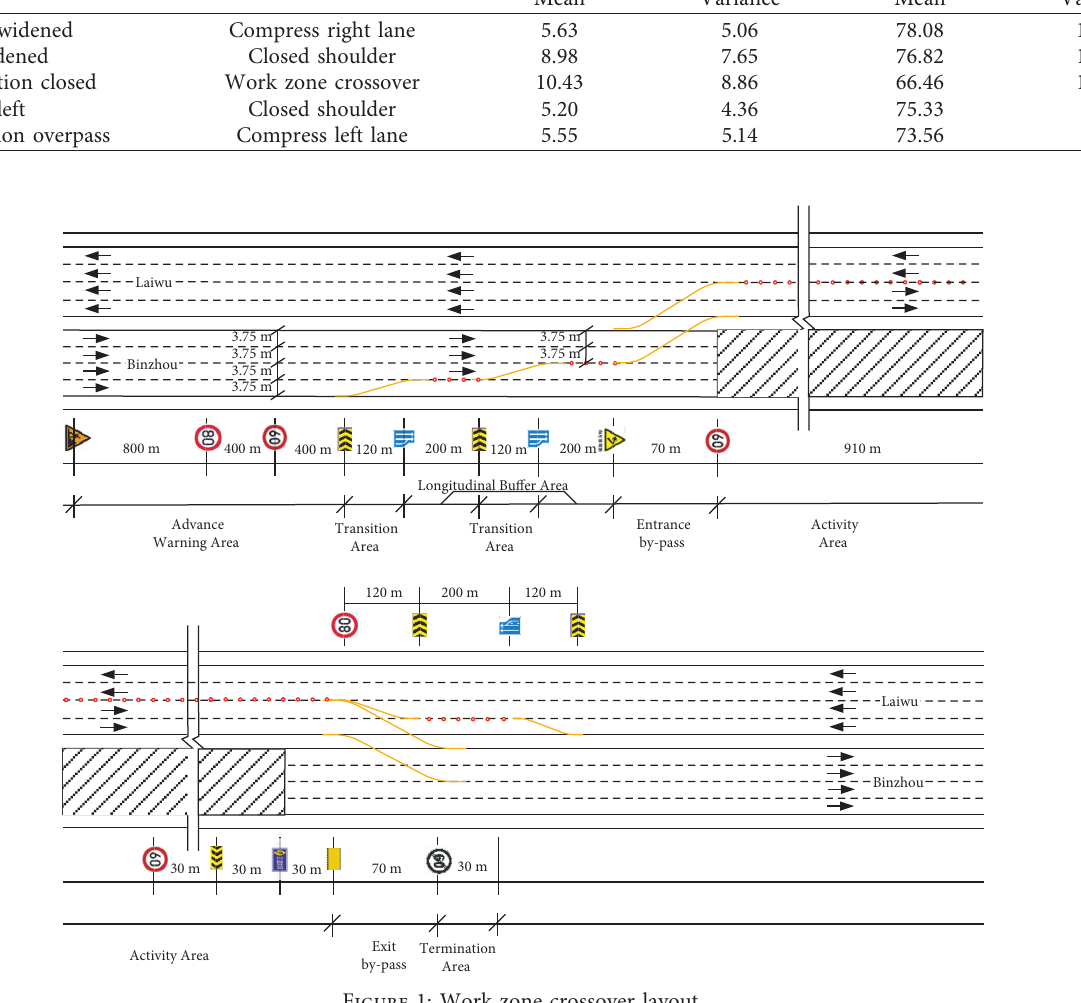
Figure 1: Work zone crossover layout.